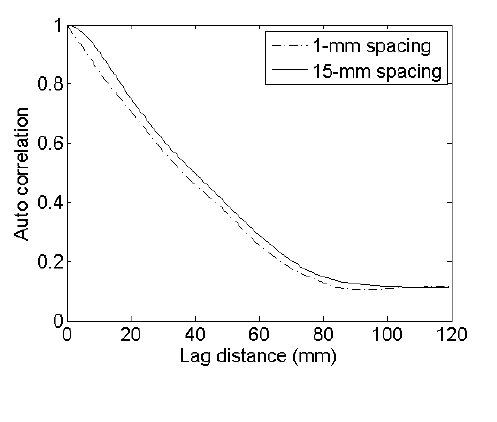
Figure 11. Autocorrelation functions derived for the same roughness profile with ( s , l ) = (1 cm,5 cm), sampled with a spacing of respectively 1 mm and 15